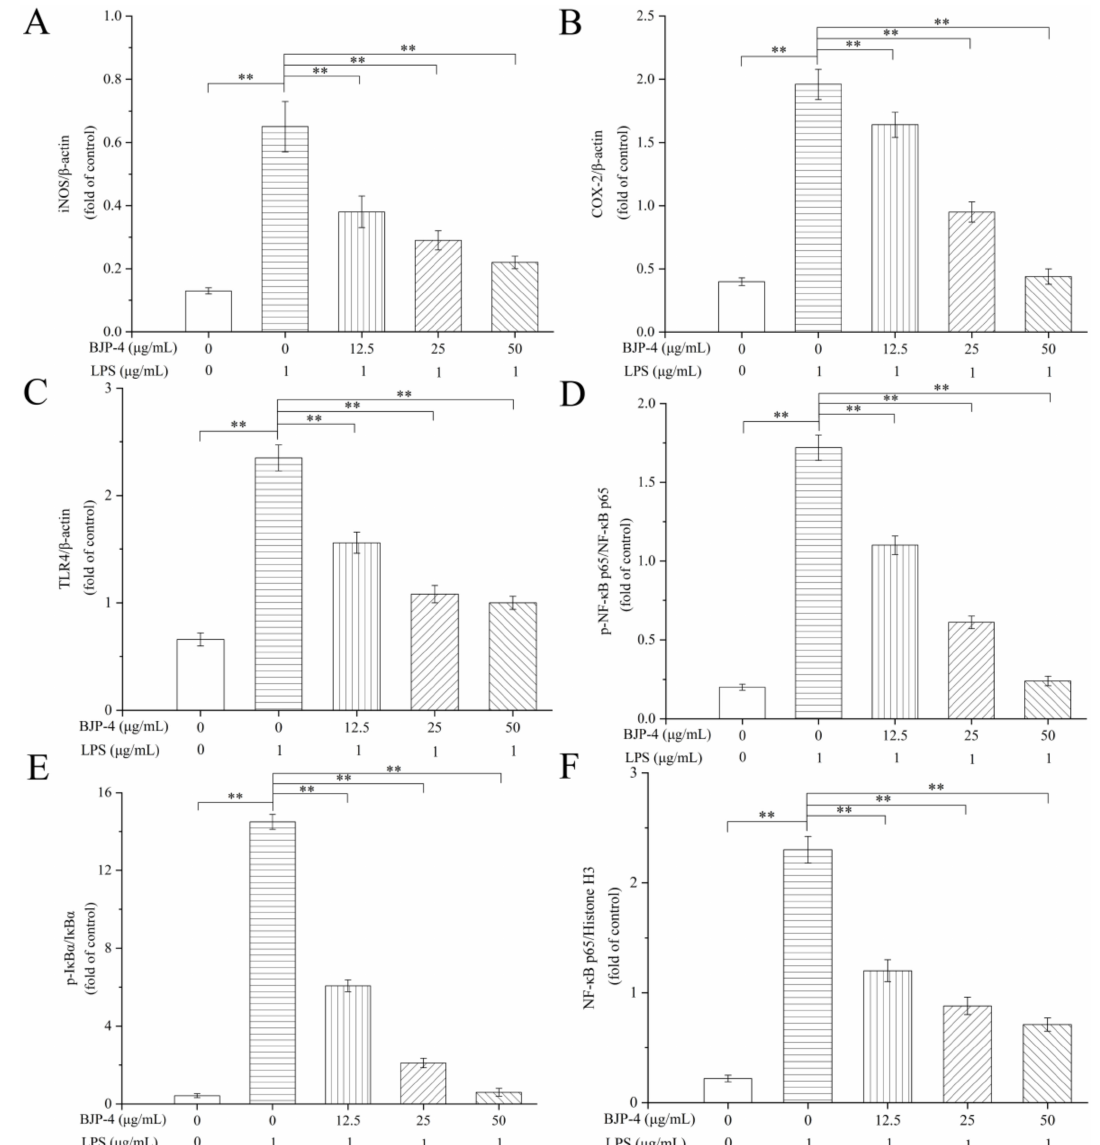
Figure 6. The protein levels of: ( A ) iNOS, ( B ) COX-2, ( C ) TLR4, ( D ) p-NF- κ B p65/NF- κ B p65, ( E ) p-I κ B α /I κ B α , ( F ) nuclear NF- κ B p65. Values are expressed as mean ± SD. ** p <